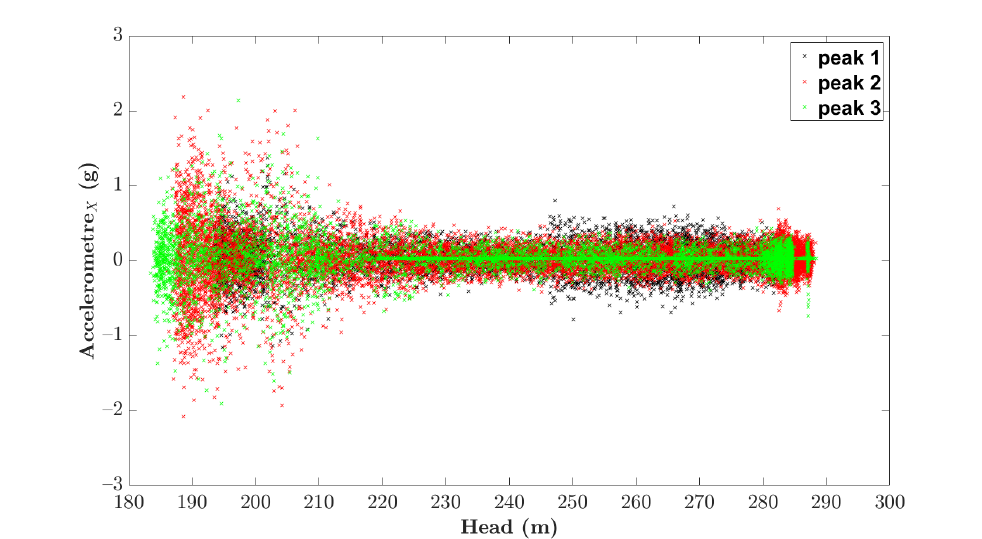
Figure 17. Correlation between the head and amplitude of the accelerometer along the x-direction. In Figure 19, pictures of the free surface in the forebay tank at four different instants during the third peak are shown. The first picture shows the free surface at the beginning of the peak, when the forebay tank is fulfilled. The second picture corresponds to a forebay tank partially emptied. The third picture shows the free surface when it passes below the top of the head race tunnel and the last picture when the free surface passes through the middle of the head race tunnel. On the last picture, one can observe the flow coming from the settling basin through the gates at the bottom left close to the entrance of the